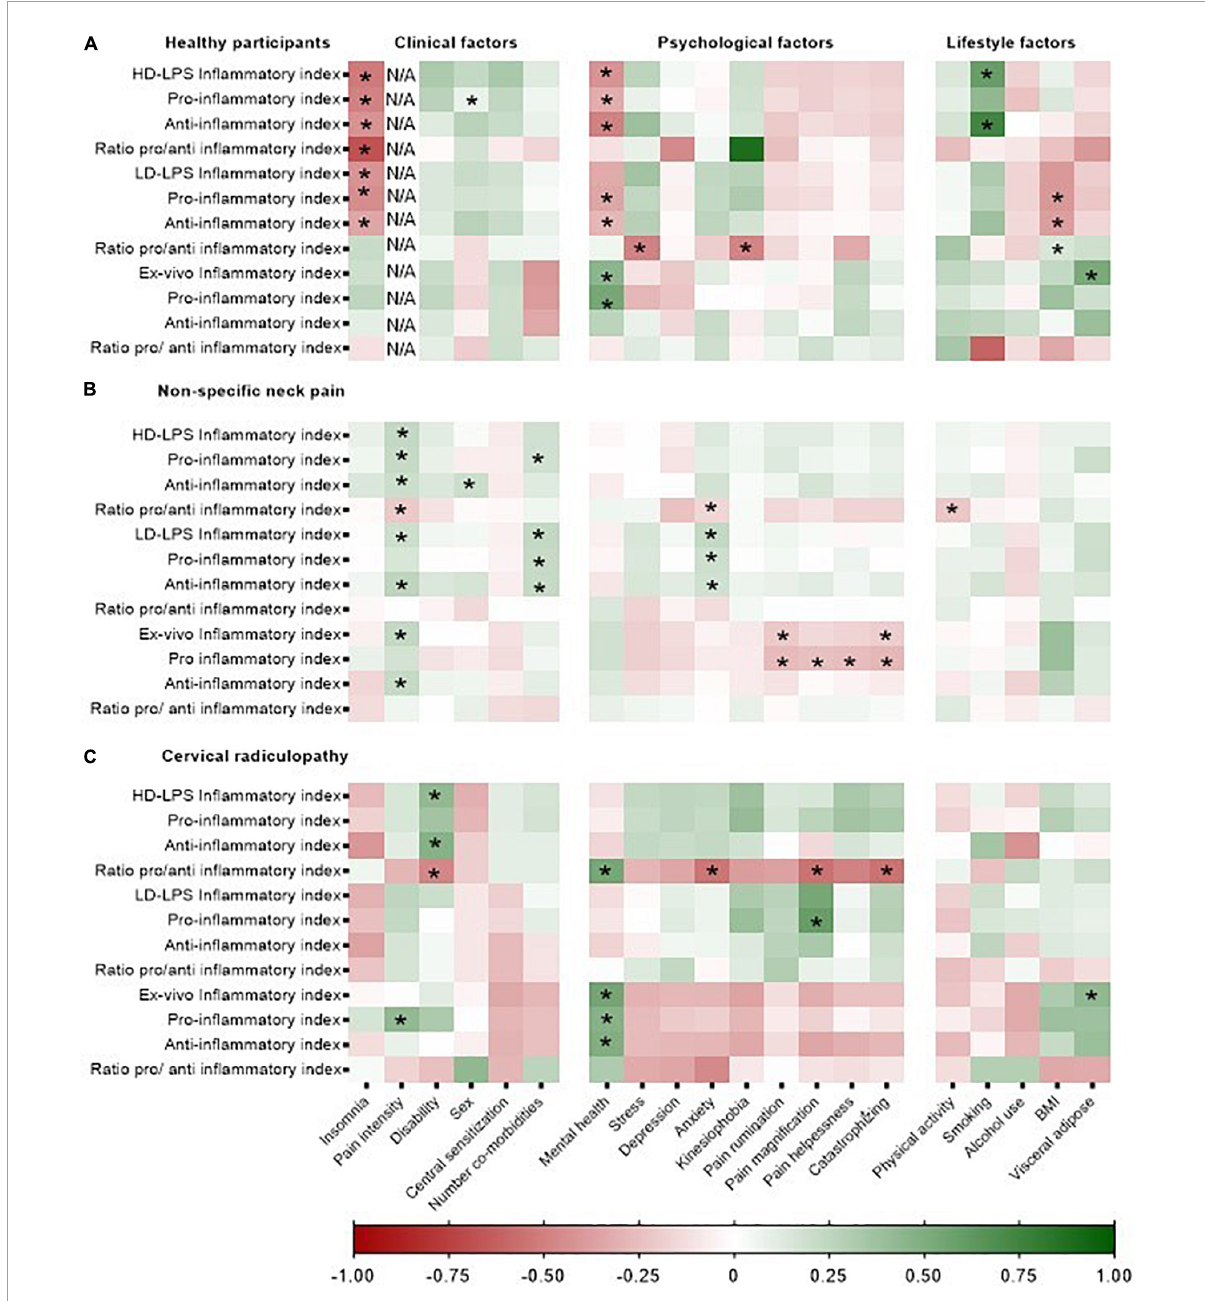
FIGURE4 Heatmap representing the strength of the associations between clinical, psychological, and lifestyle factors and the in vitro whole blood response and inflammatory indices in healthy participants, non-specific neck pain, and cervical radiculopathy. Inflammatory markers were Ln-transformed and expressed as standardized-B. In vitro inflammatory indices were /1,000 monocytes normalized. HD-LPS, high dose – LPS stimulation, 10 µ g/ml; LD-LPS, low-dose LPS stimulation, 1 ng/ml. “*”Represent a significant association ( p < 0.05). The heatmap was based on the data of 112 people with non-specific neck pain, 25 with cervical radiculopathy, and 23 healthy participants. (A) Represents the heatmap for the healthy participants, (B) represents the heatmap for the people with non-specific neck pain and (C) represents the heatmap of the people with a cervical